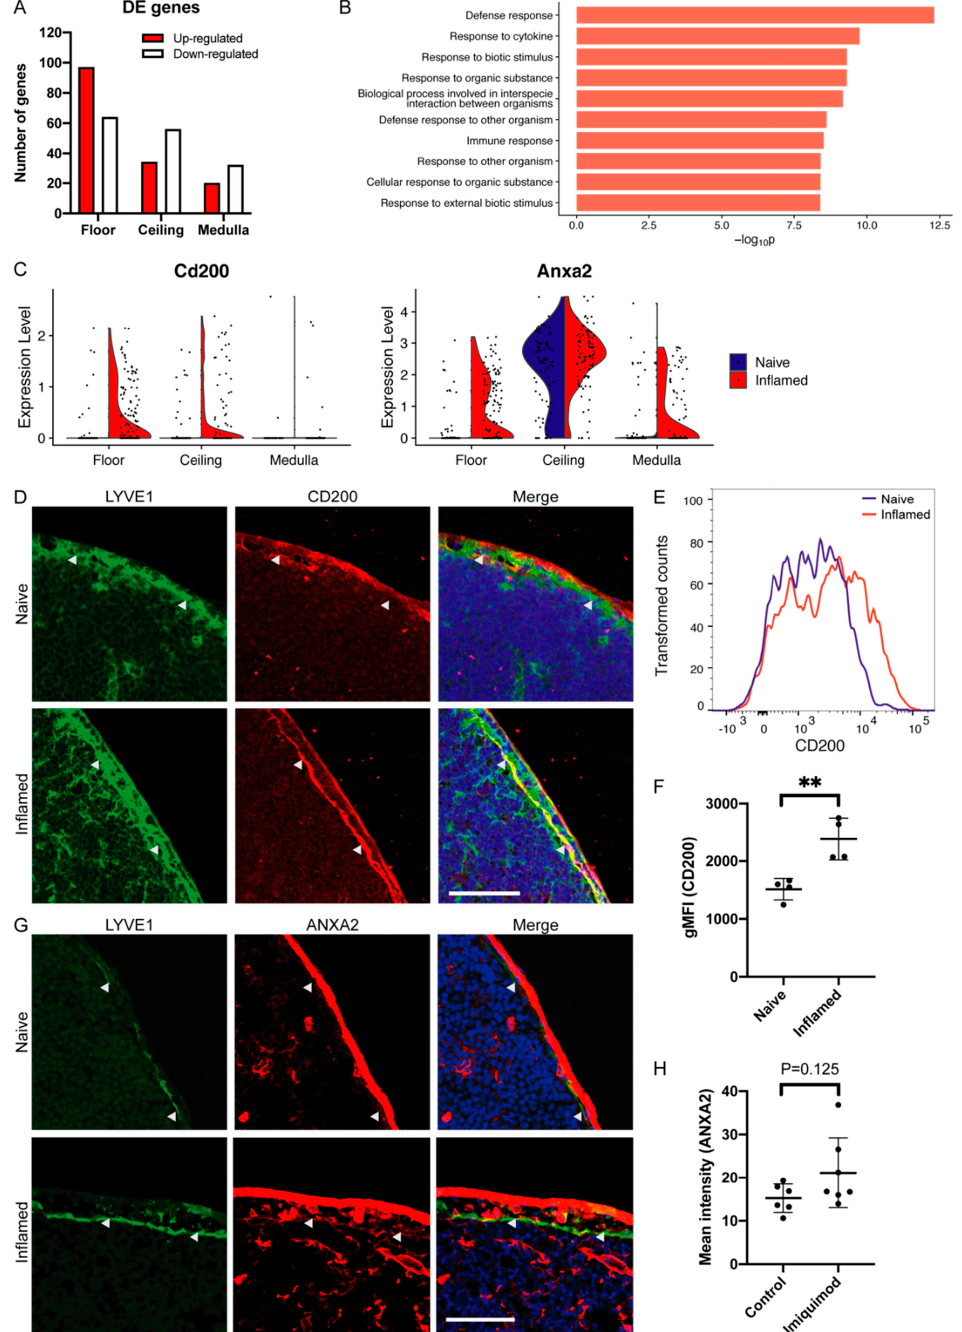
Figure 2. Differential gene expression between LN LECs from naïve and inflamed conditions. ( A ) The number of genes up- and down-regulated in inflammation versus naïve conditions in each LEC subset (log 2 FC > 0.2 and adjusted p < 0.05). ( B ) Top 10 GO terms of biological processes enriched for genes differentially expressed in inflammation in floor LECs ( p < 0.05, ranked by p values). ( C ) Violin plots showing up-regulation of Cd200 and Anxa2 in the floor LECs during inflammation. ( D ) Representative immunofluorescence images of CD200 in LNs from naïve and inflamed conditions. Arrowheads: SCS floor, scale bar 50 µ m. ( E ) FACS plot showing a representative histogram of CD200 expression on LECs, from naïve and inflamed LNs. ( F ) Expression of CD200 by LN LECs under naïve and inflamed conditions measured by FACS ( n = 4). Mean + SD, p ≤ 0.01 **. ( G ) Representative immunofluorescence images of ANXA2 in LNs from naïve and inflamed conditions. Arrowhead: SCS floor, scale bar 50 µ m. ( H ) Quantification of ANXA2 expression in floor LECs in LN sections, mean intensity of ANXA2 staining in LYVE1 + area averaged over 2–5 images per replicate ( n = 6 naïve resp. 7 inflamed). Mean +